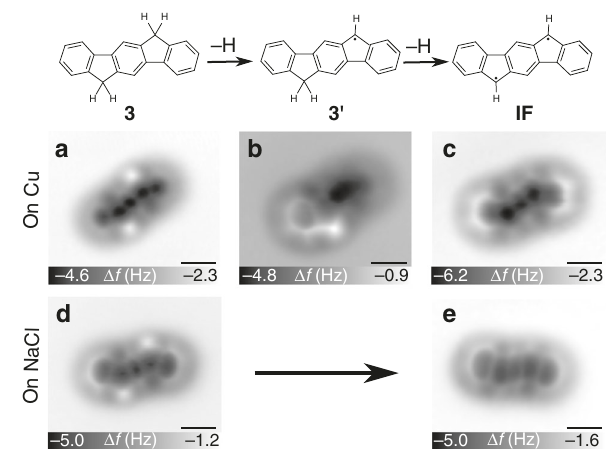
Fig. 3 On-surface generation of indeno[1,2- b ] fl uorene ( IF ). 6,12- Dihydroindeno[1,2- b ] fl uorene ( 3 ) was dehydrogenated with bias pulses typically between 3.5 and 4.3 V. a – e Constant-height AFM images of the precursor molecule 3 ( a , d ), of radical 3 ′ ( b ) and IF ( c , e ) measured with a CO tip at V = 0 on Cu(111) ( a – c ) and on 2 ML NaCl ( d , e ), respectively. Images were taken at tip height offsets a Δ z = − 1.3 Å, b Δ z = − 2.0 Å, c Δ z = − 2.5 Å, d Δ z = 1.7 Å and e Δ z = 1.5 Å with respect to the STM setpoint of I = 1.0 pA and V = 0.1 V above the respective substrate. Scale bars, 500